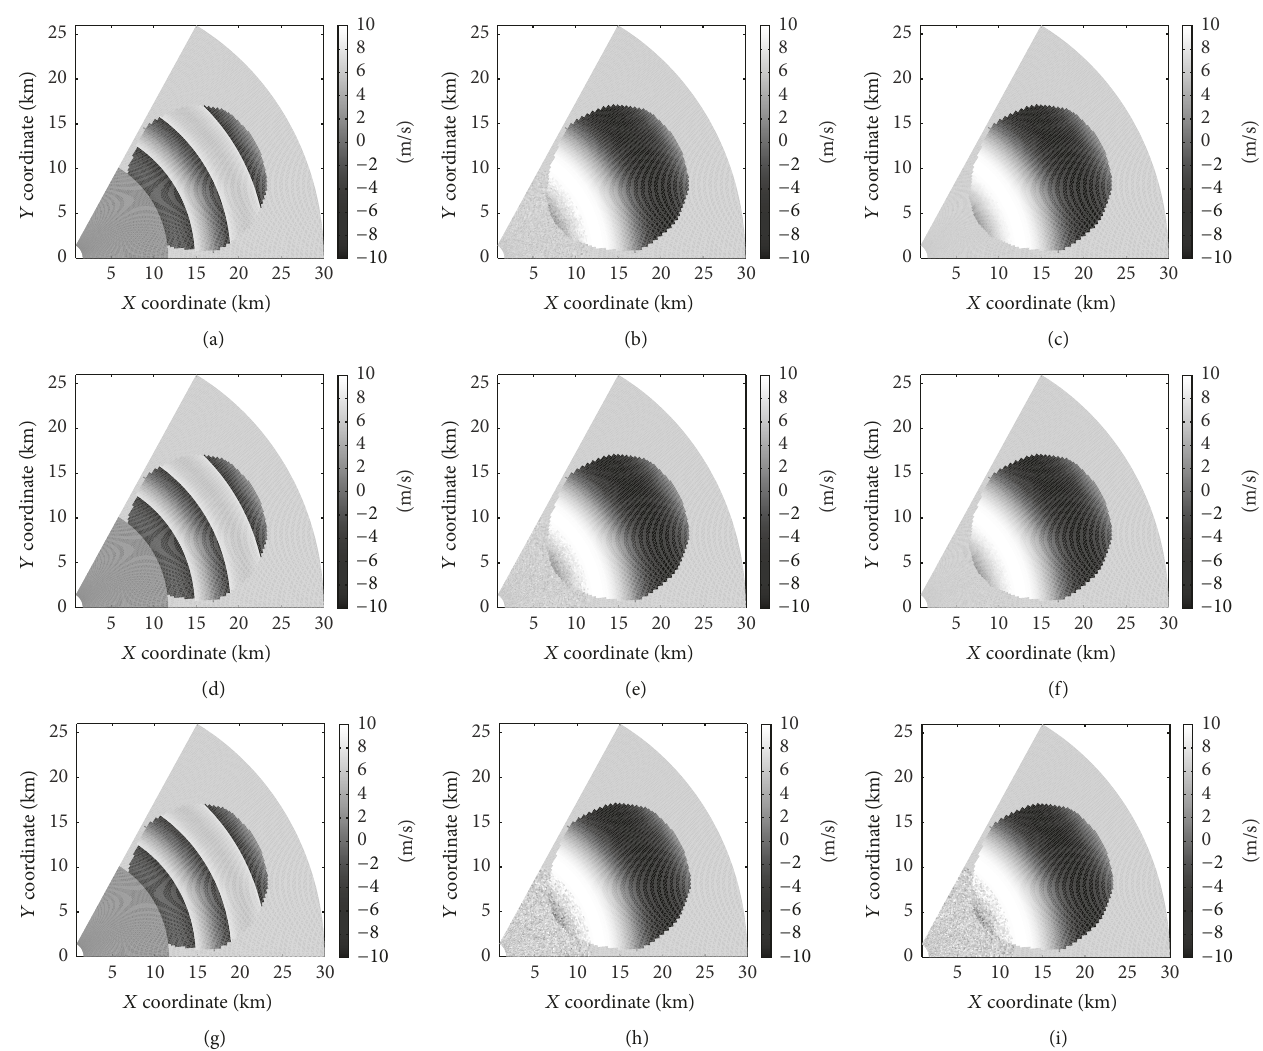
Figure 5: Radial velocity estimated from simulated 𝐼 and 𝑄 radar data sampled at ((a), (d), (g)) unique PRT of 1050 𝜇 s, ((b), (e), (h)) 2-PRT (1050 and 1200 𝜇 s), and ((c), (f), (i)) 4-PRT (1050, 1200, 1500, and 1950 𝜇 s) with SNR = 40 dB and different CSR scenarios: (a)–(c) CSR = 10dB, (d)–(f) CSR = 20dB, and (g)–(i) CSR = 30 dB. Note that the data are shown for 30 km × 60 ∘ space. The range and azimuth resolutions are 150 m and 1 ∘ , respectively. The corresponding unambiguous velocities are 7.14m/s for unique PRT and 50 m/s for the other two schemes. The pulse pair processing (PPP) method is used in (a), (d), and (g). The PTDM is used in the